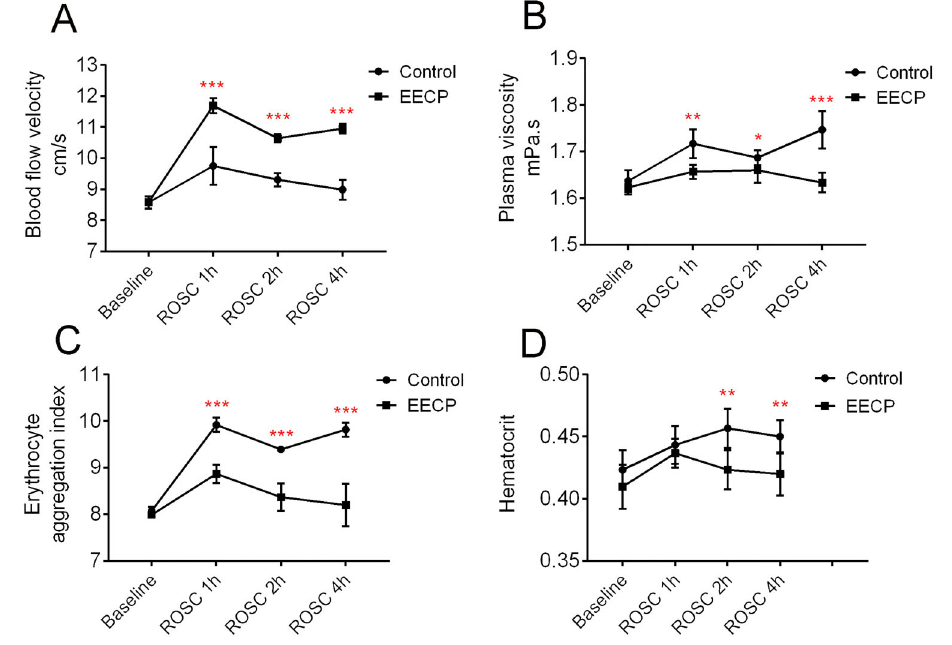
Figure 1. Enhanced external counterpulsation (EECP) improved the hemorheology of dogs after return of spontaneous circulation (ROSC). A , EECP increased blood fl ow velocity; B , EECP decreased plasma viscosity; C , EECP decreased erythrocyte aggregation index; D, EECP slightly decreased hematocrit. Data are reported as means ± SD. *P o 0.05, **P o 0.01, ***P o 0.001 (ANOVA).